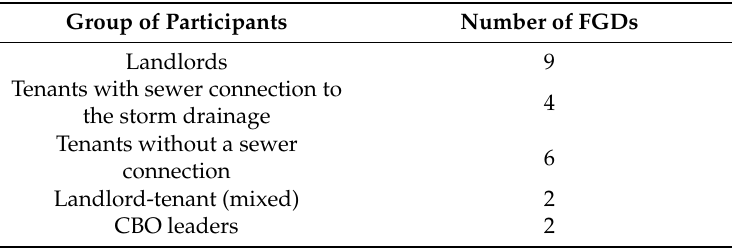
Table 2. Number of focus group discussions (FGDs) with slum